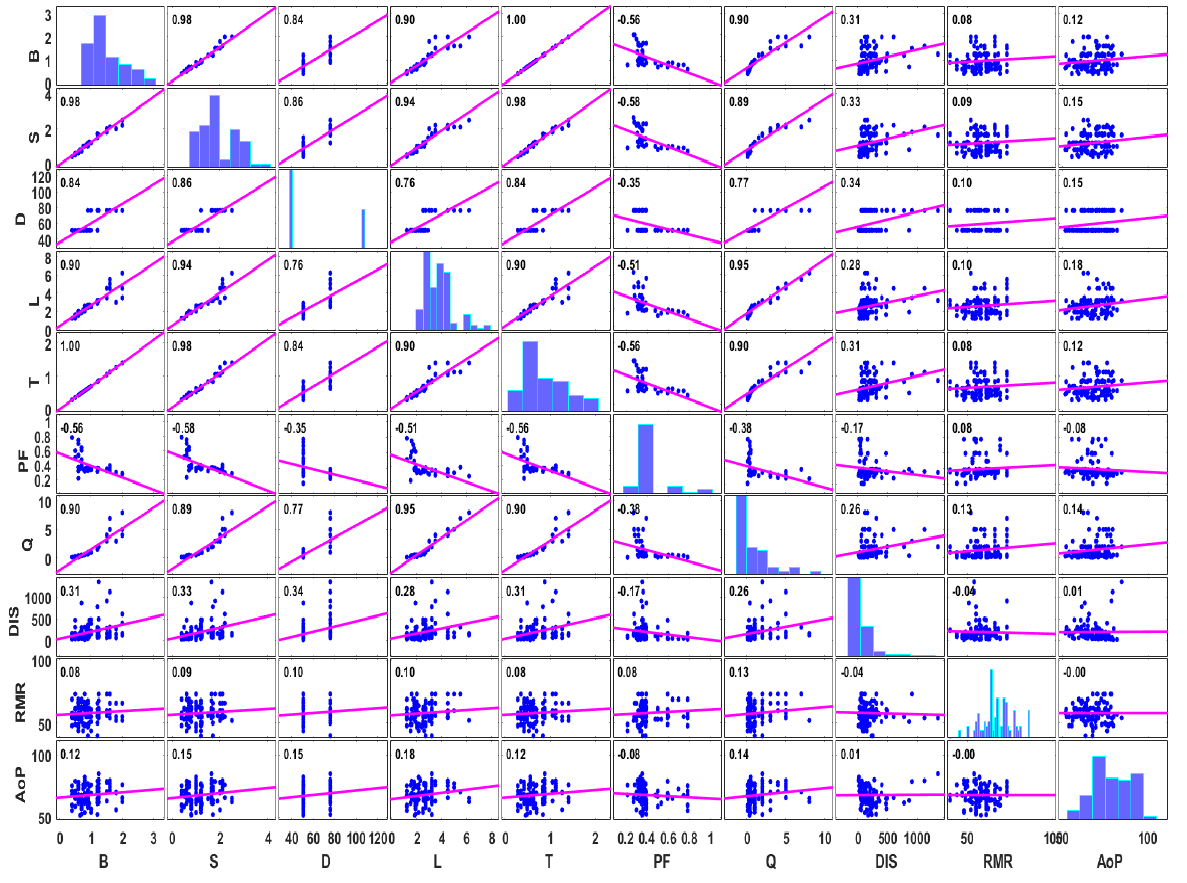
Figure 3. Correlation plot depicting the relationships between AOp model parameters .